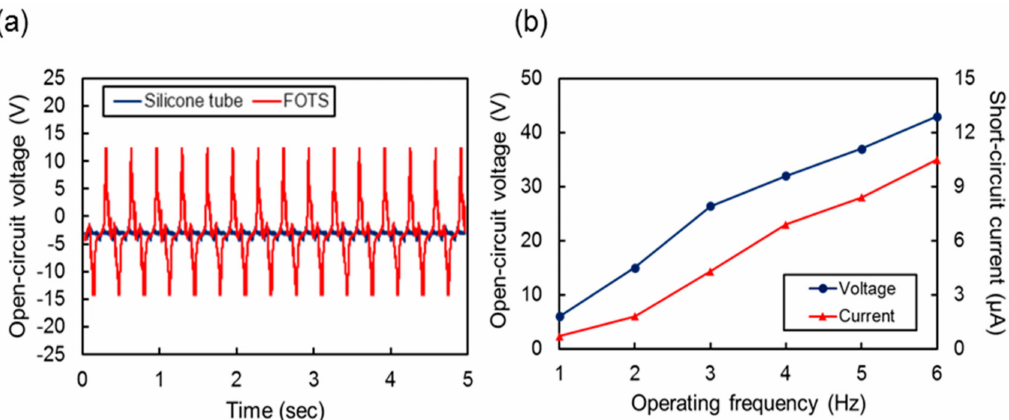
Figure 6. ( a ) Real time profiles of open-circuit output voltages measured at frequency of 3 Hz with vertical force of 10 N with and without 2H-perfluorrooctyltrichlorosilane (FOTS) coating. ( b ) Peak-to-peak open-circuit voltage and short-circuit current from single thread at various operation